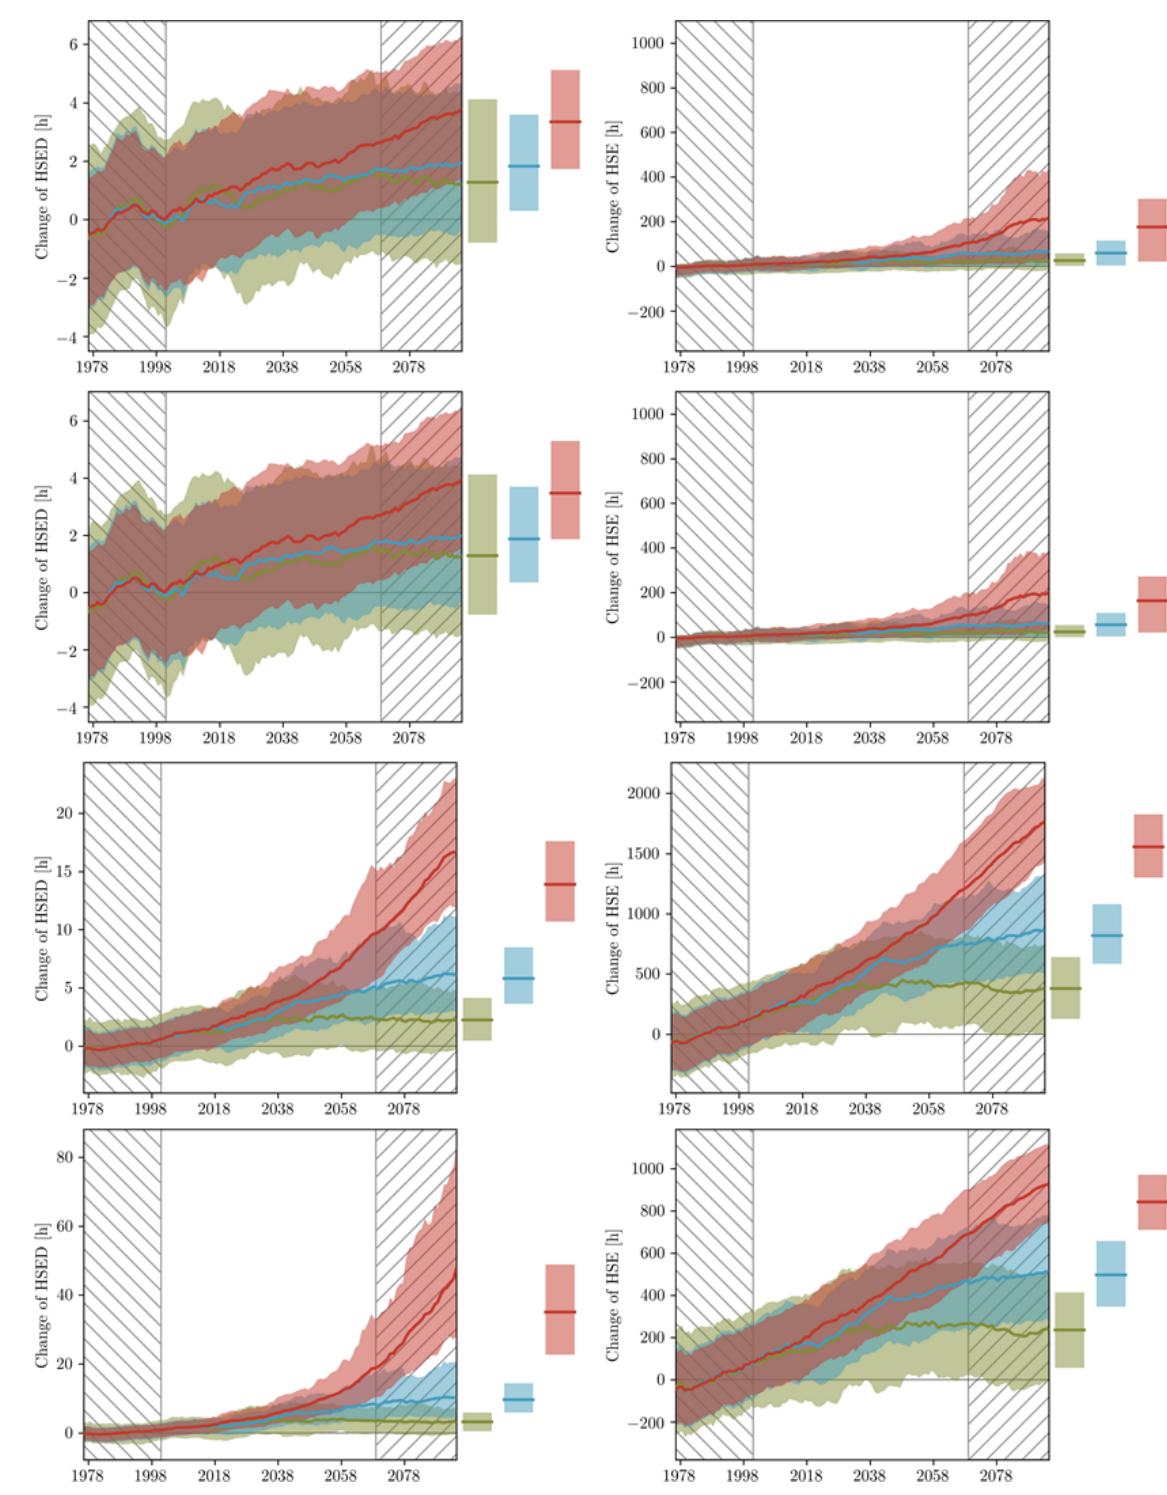
Figure 5. Projected change in heat stress events in the reference barns in maritime regions in central Europe (top two rows) versus Mediter- ranean region (bottom two rows). Modifications in annual (first row) and summer (second row) average of duration (average consecutive hours) and number (number of consecutive hours) of moderate stress events under RCP 2.6 (green), RCP 4.5 (blue) and RCP 8.5 (red) are plotted based on the temperature humidity index (THI) with a threshold of